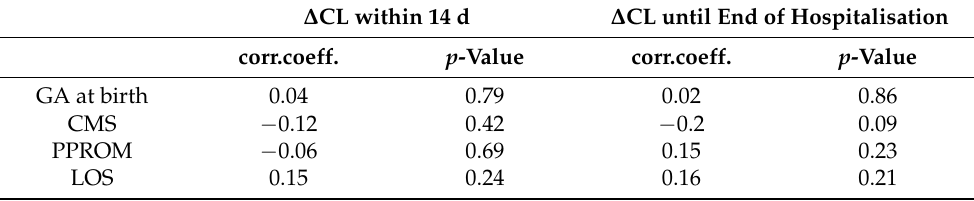
of the membranes (PPROM), and length of stay